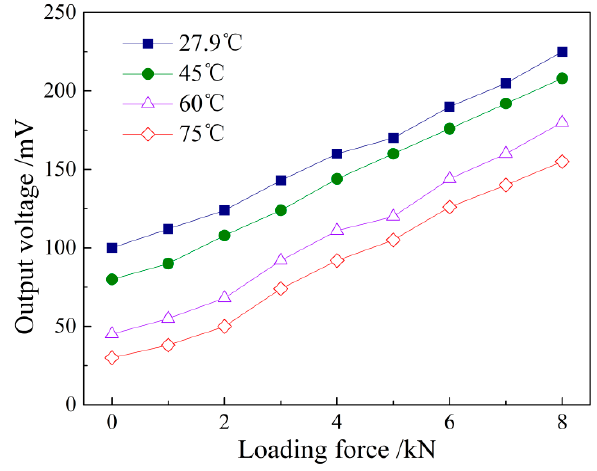
Figure 12. The output voltage with loaded stress at different temperatures.